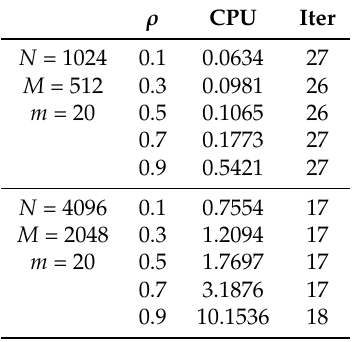
Table 4. The convergence behavior of Algorithm 4 with different cases of ρ .